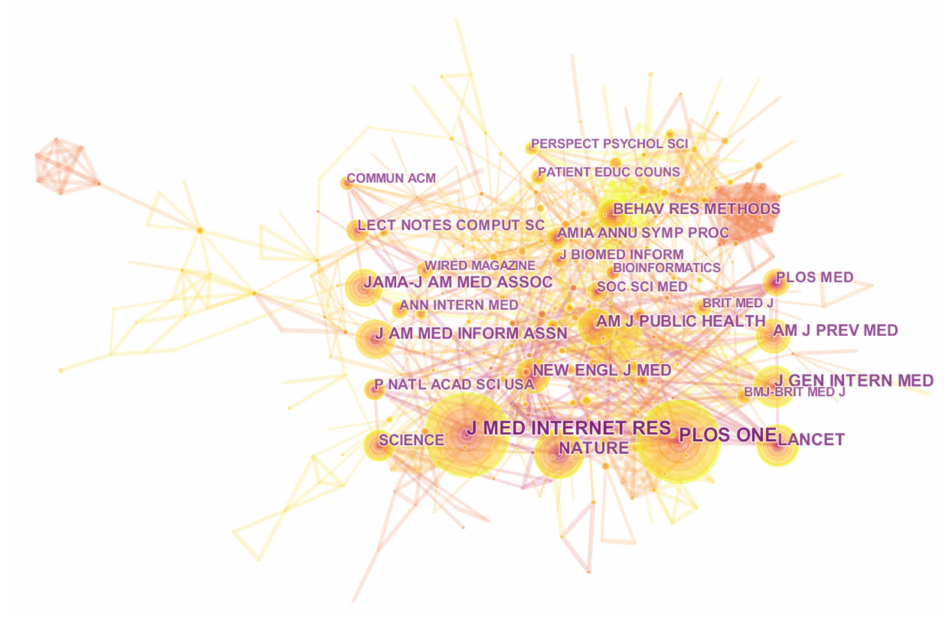
Figure 5. Visualization of co-citation journals analysis